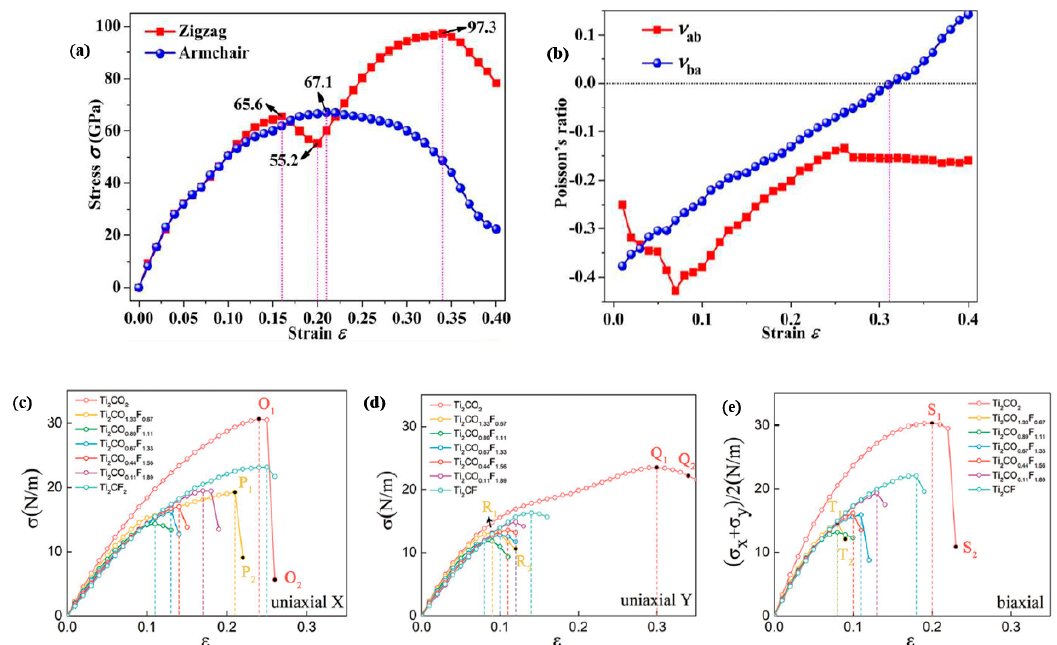
Figure 6. ( a ) Stress-strain curves of intrinsic W 2 C under uniaxial stretching, ( b ) Poisson’s ratios of W 2 C stretched along with different directions. Reproduced with permission from [ 53 ] . Copyright RSC, 2018. The calculated stress σ versus strain ε curves for Ti 2 CT 2 with pure and mixed terminations under ( c ) uniaxial x , ( d ) uniaxial y , and ( e ) biaxial loading conditions. Reproduced with permission from [ 55 ] . Copyright John Wiley & Sons, 2018.